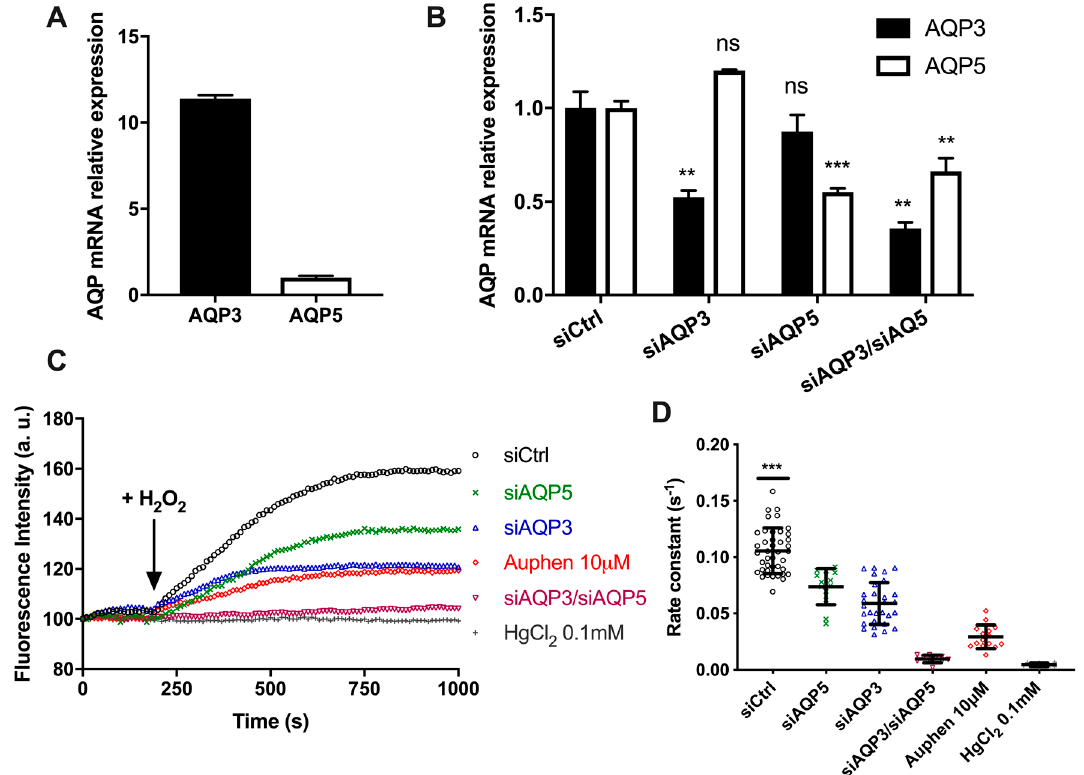
Figure 6. AQP5-mediated H 2 O 2 uptake in pancreatic cancer cells. ( A ) AQP3 and AQP5 mRNA expression levels in BxPC3 cells using β -actin as a reference; ( B ) AQP3 and AQP5 mRNA expression levels in BxPC3 cells transiently transfected with siAQP3 and siAQP5. Data represent mean ± SEM from three independent experiments. Significance levels: ns, non-significant, ** p < 0,01, *** p < 0.001 vs. siCtrl; ( C ) Representative traces of H 2 -DCFDA fluorescence increase after addition of 100 µ M H 2 O 2 ; ( D ) First-order kinetic rate constant (s − 1 ) of H 2 O 2 influx through endogenous AQP3 and AQP5 expressed in BxPC3 cells after addition of 100 µ M H 2 O 2. Data shown are individual values and mean ± SEM of three independent experiments. Significance levels: *** p < 0.001 vs. siAQP5, siAQP3, siAQP5, siAQP3 / siAQP5, Auphen 10 µ M and HgCl 2 0.1 mM.